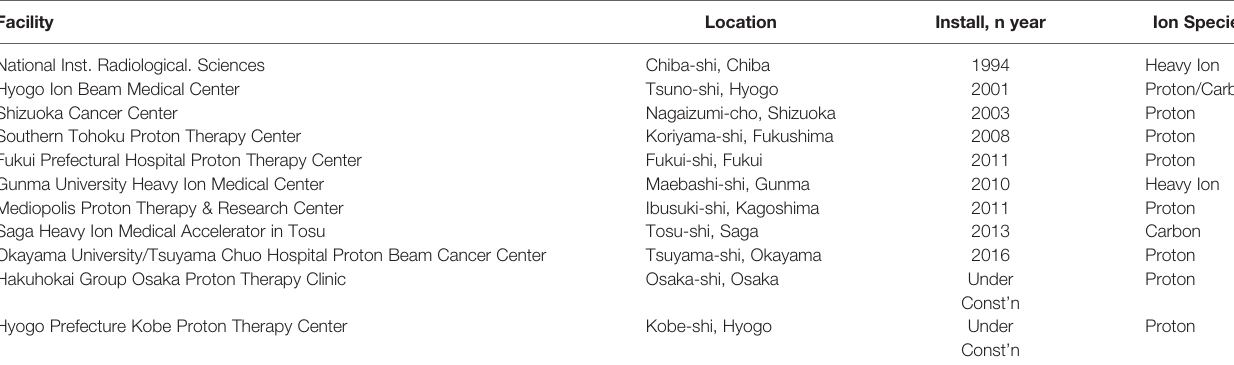
TABLE 5 | Mitsubishi particle therapy systems